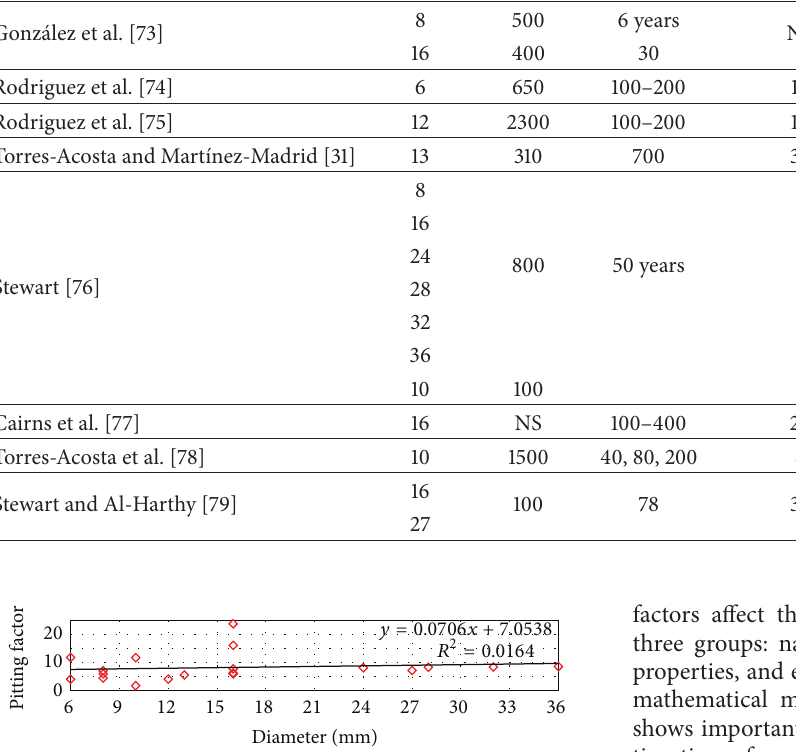
Figure 4: Pitting factor for different diameter sizes of bars regresses from results represented in Table